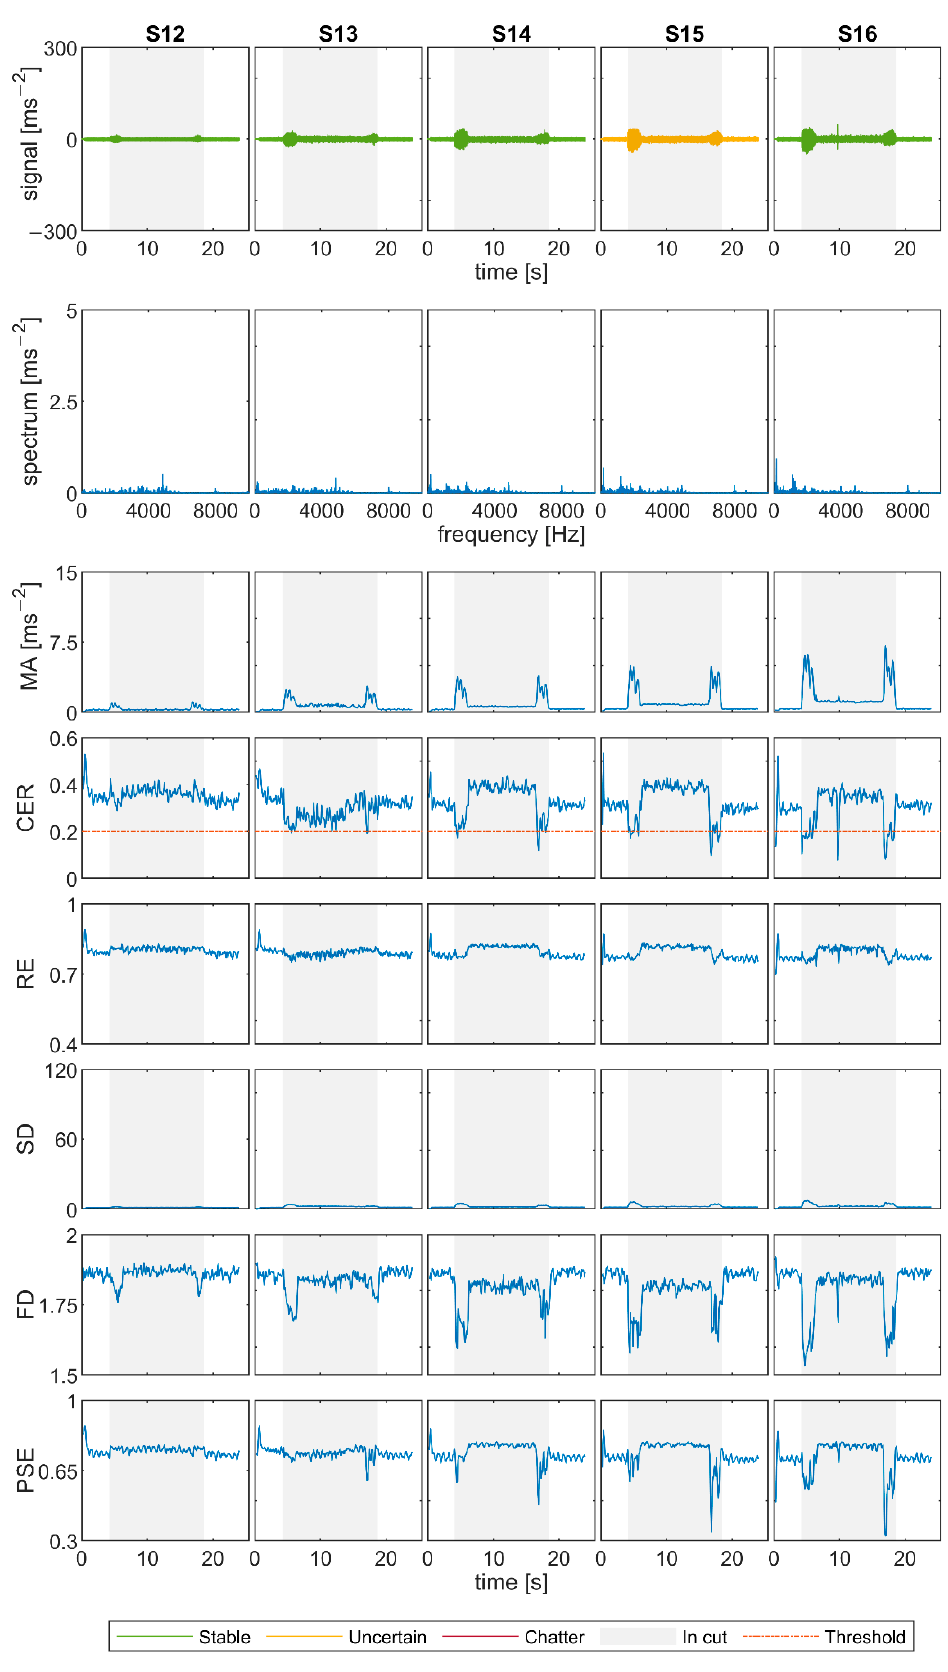
Figure A3. Signals from Experiment 3—shoulder mill.